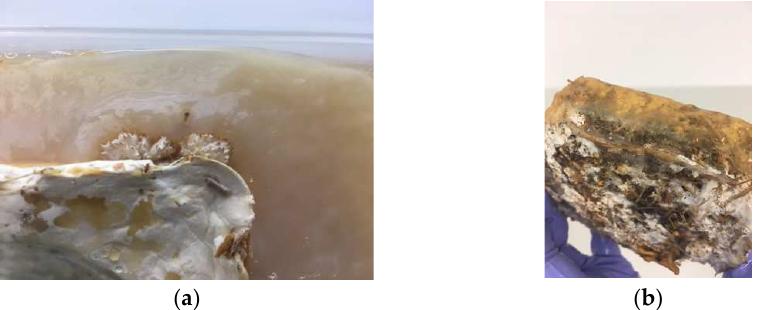
Figure 6. ( a ) Thicker BC growth around dried fruiting body. ( b ) BC skin around submerged half of mycelium tile after harvest (image credit: